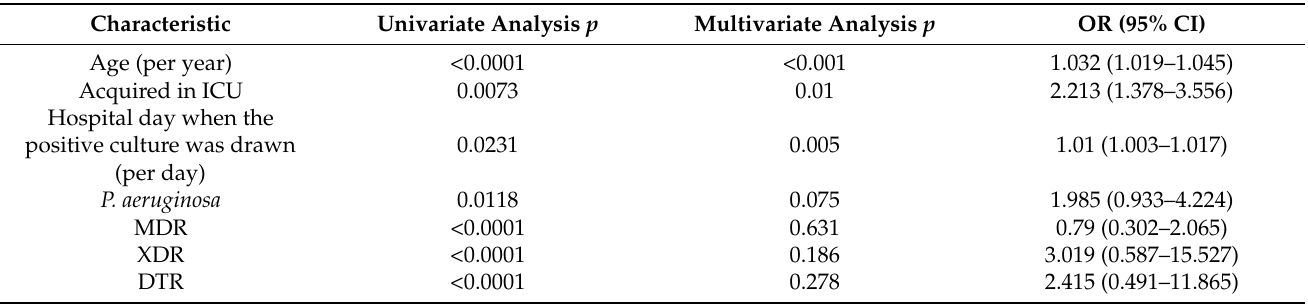
Table 6. Results of the regression analysis regarding patient mortality at 30 days after the occurrence of Pseudomonas spp.